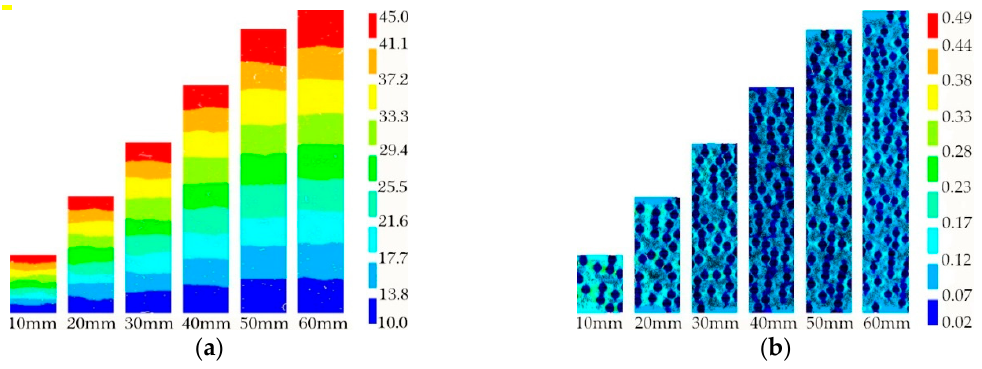
Figure 8. ( a ) Temperature nephogram; ( b ) Thermal vector nephogram.